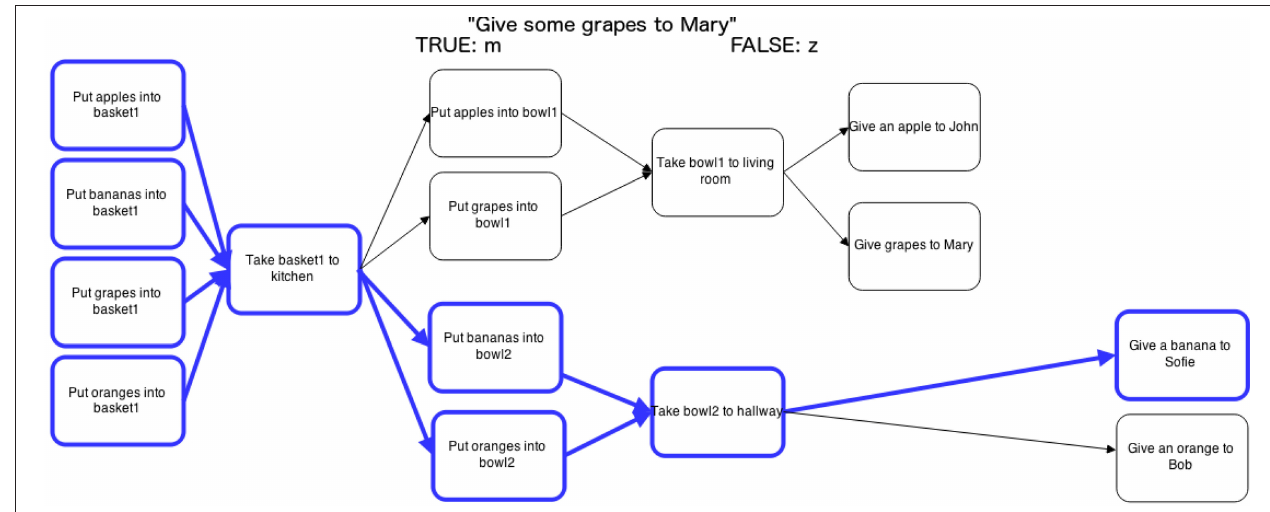
FIGURE 3 | Experiment 3, one experimental trial: plan and statement. The highlighting is unhelpful for a statement about grapes, while the highlighting is helpful for bananas. The statement (“Give some grapes to Mary”) is true since the step with grapes nevertheless is present in the